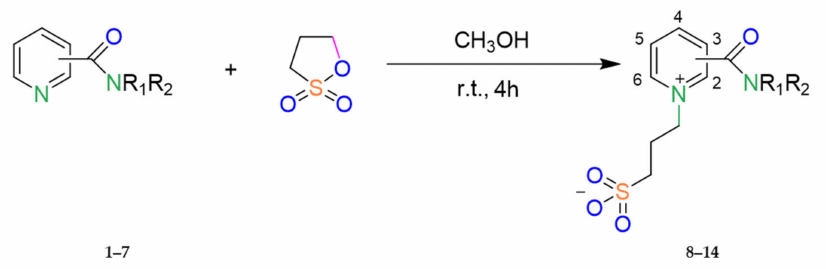
Table 1. Reagents, products, and product yields. Reagent Structure Product Product Structure